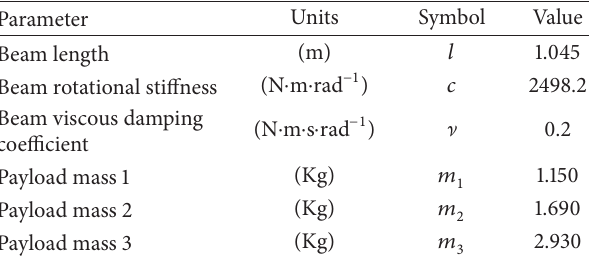
Table 1: Flexible robot